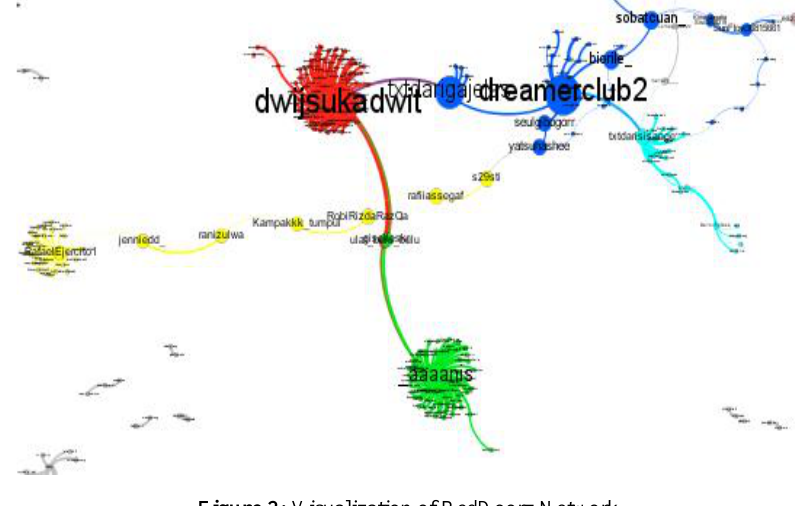
Figure 2: Visualization of RedDoorz